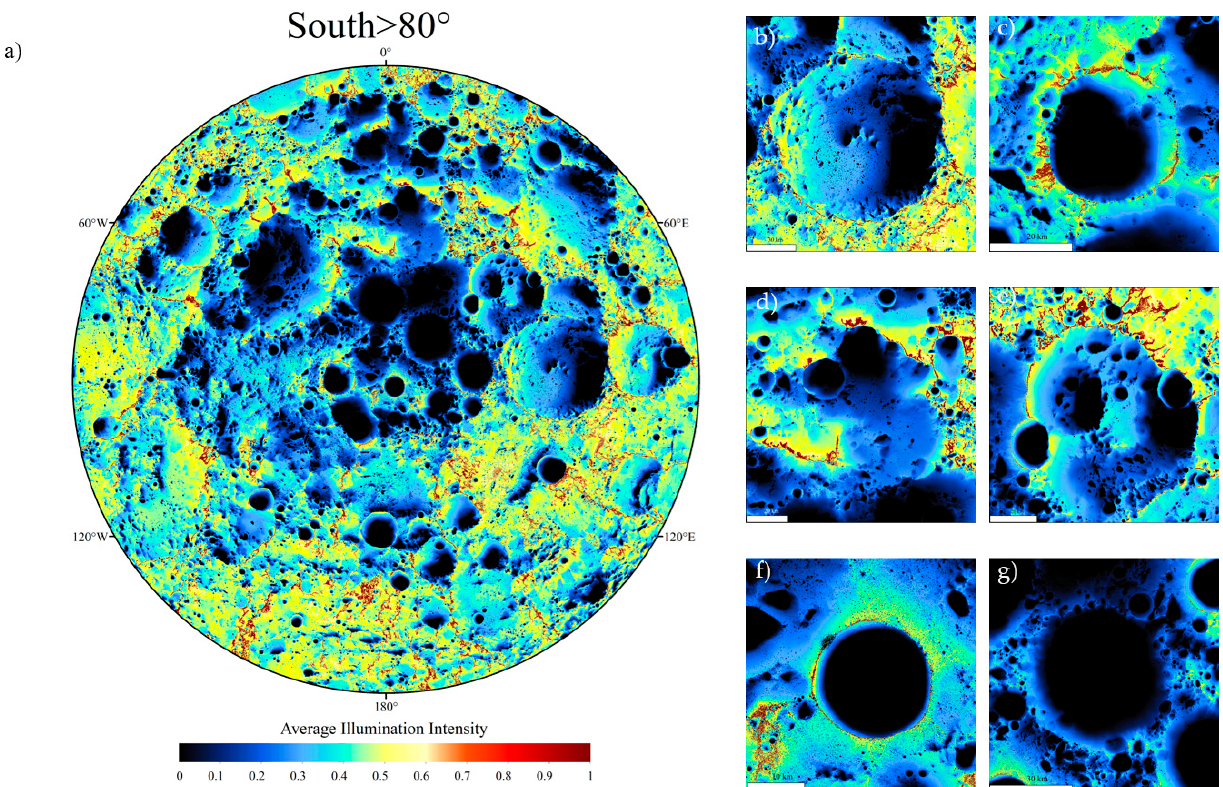
Figure 14. Map of average illumination intensity at the lunar south pole in the area above 80° south latitude (shown in ( a ), and also for the following impact craters: ( b ) Amundsen; ( c ) de Gerlache; ( d ) Malapert; ( e ) Nobile; ( f ) Shackleton; and ( g ) Shoemaker. ( d ) Malapert; ( e ) Nobile; ( f ) Shackleton; and ( g )